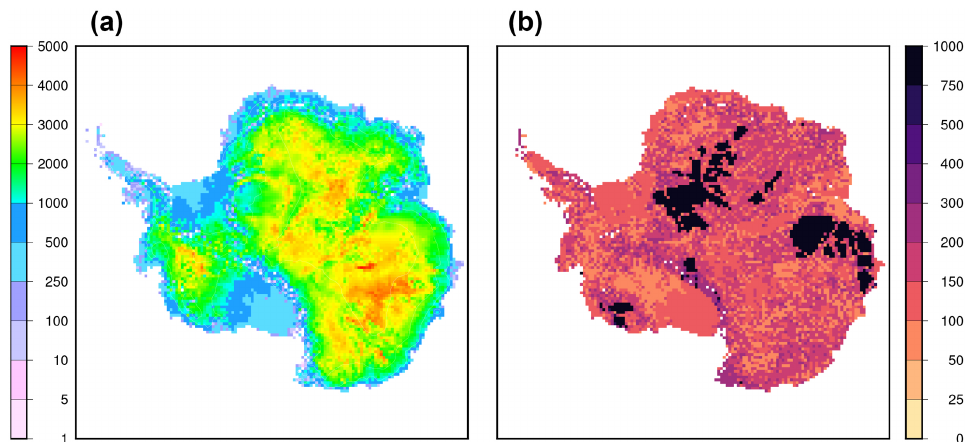
Figure 4. Bedmap2 ice thickness (a) and associated uncertainty (b) in metres (Fretwell et al., 2013), interpolated on the GRISLI grid of Antarctica at 40 km resolution. Despite considerable improvements from Bedmap1, large areas present an important uncertainty ( ± 1000m) due essentially to poor in situ data coverage.